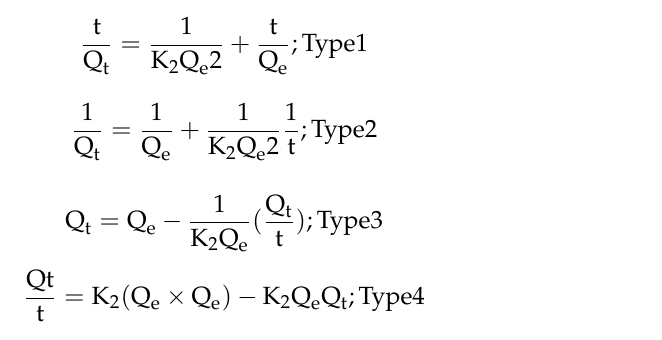
The kinetic constants including Q eq , Q t , K 1 , K 2 and R 2 respectively for the AB 113 adsorption onto IRA 402(Cl − ) mass were determined and are presented in Table 1. Appli- cability of the kinetics model was carried out by correlation coefficient (R 2 ) evaluation of obtained linear regression. Moreover, analyzing experimental data presented in Table 1, ob- tained when fitting kinetics results, it was found in Figure 2a that R 2 for the PFO model are greater than for PSO models modulated as: t/Q t vs. t (Figure S1); 1/Q t vs. 1/t (Figure S1); Q t vs. Q t /t (Figure S1) and Q t /t vs. Q t (Figure S1). The determined values of Q eq